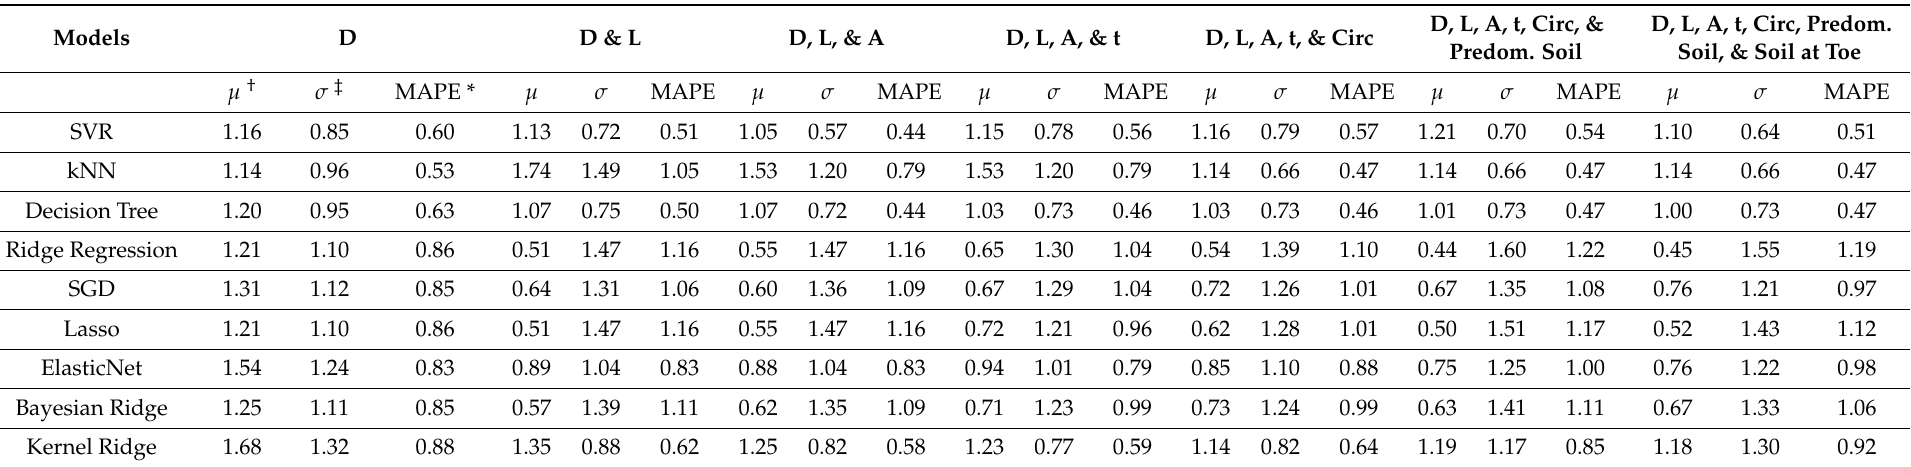
Table 2. Testing performance of the models with the various